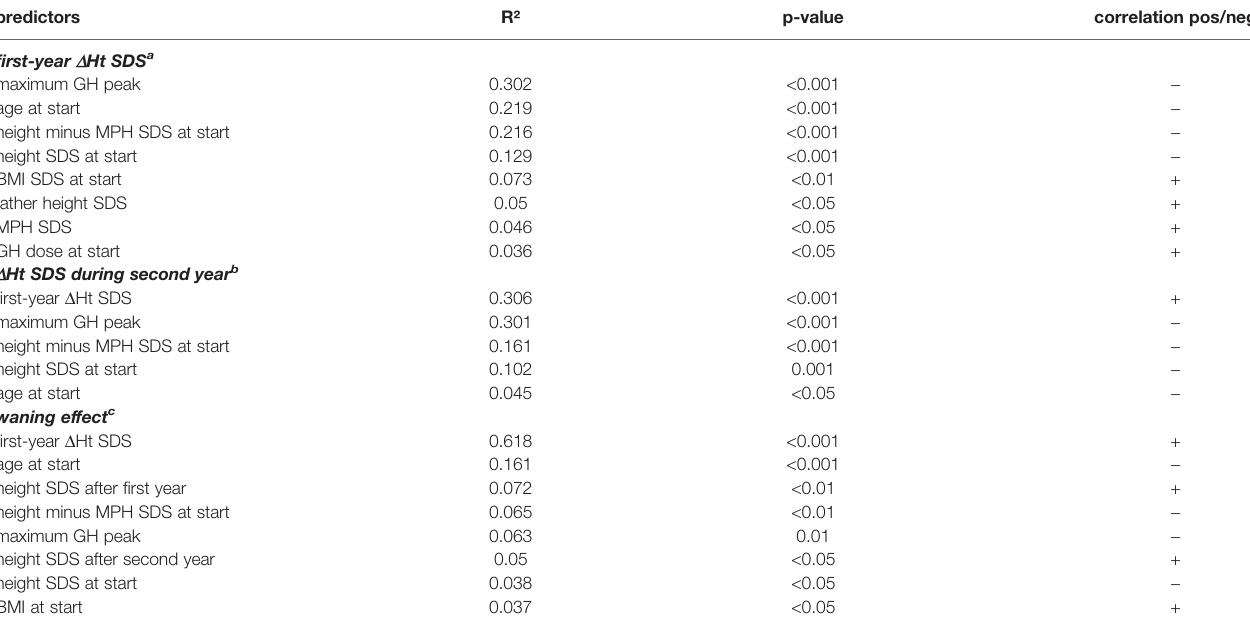
a gain in height SDS after 1 year of GH treatment; b gain in height SDS after 2 years of GH treatment; c waning effect, fi rst-year D Ht SDS minus D Ht SDS during second year; GH, growth hormone; GHD, GH de fi cient; R², the coef fi cient of determination; pos, positive correlation; neg, negative correlation; MPH, mid parental height; BMI, body mass index.